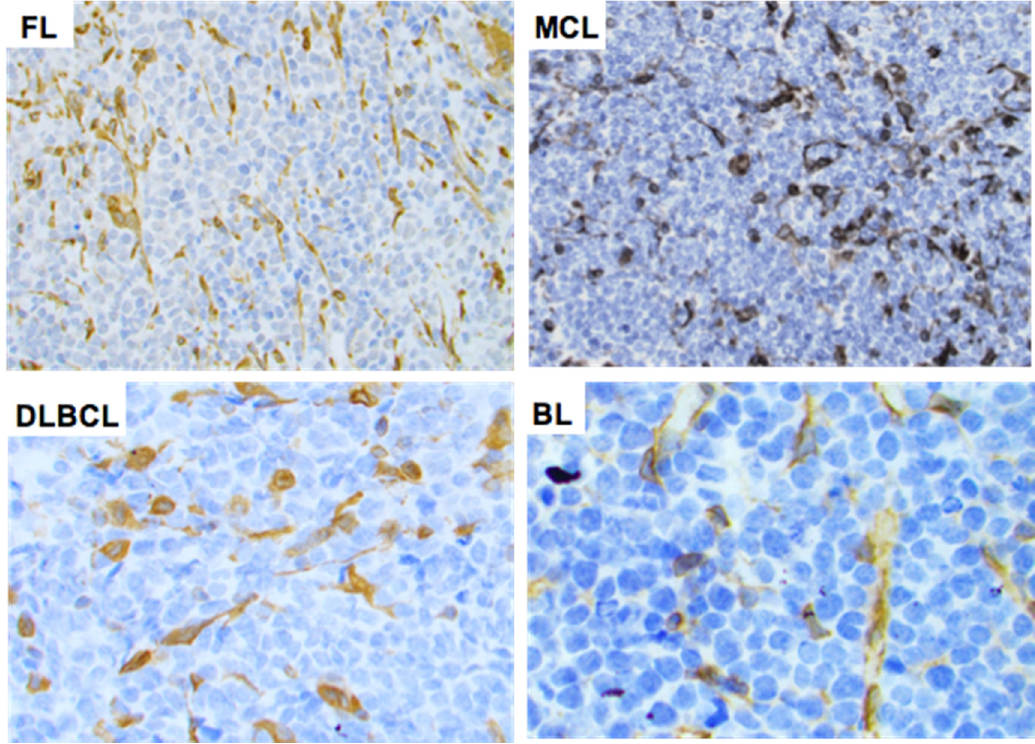
Figure 4. Expression of STING in B-cell non-Hodgkin lymphomas. STING expression was negative in the neoplastic cells of all B-cell NHL tumors assessed. Representative examples of follicular lymphoma (FL), mantle cell lymphoma (MCL), diffuse large B-cell lymphoma (DLBCL), and Burkitt lymphoma (BL) are shown. Original magnification × 400. DAB as